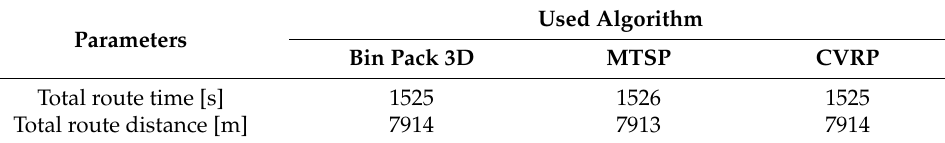
Table 3. Experiment